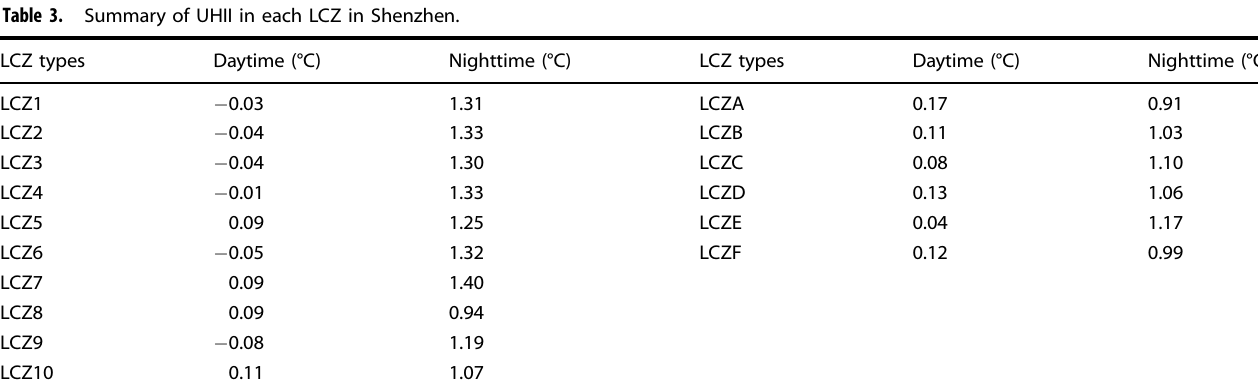
Table 3. Summary of UHII in each LCZ in